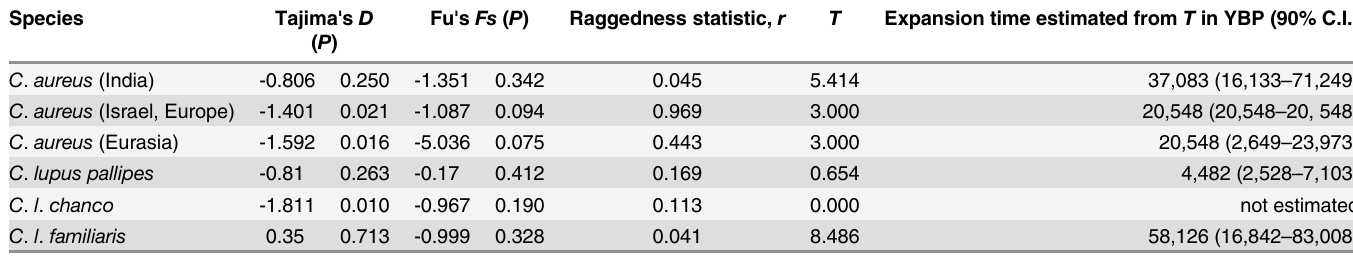
Table 5. Demographic expansion parameters estimated from control region sequences, for golden jackal and related wolf and feral dog lineages in India. T is the coalescent time of